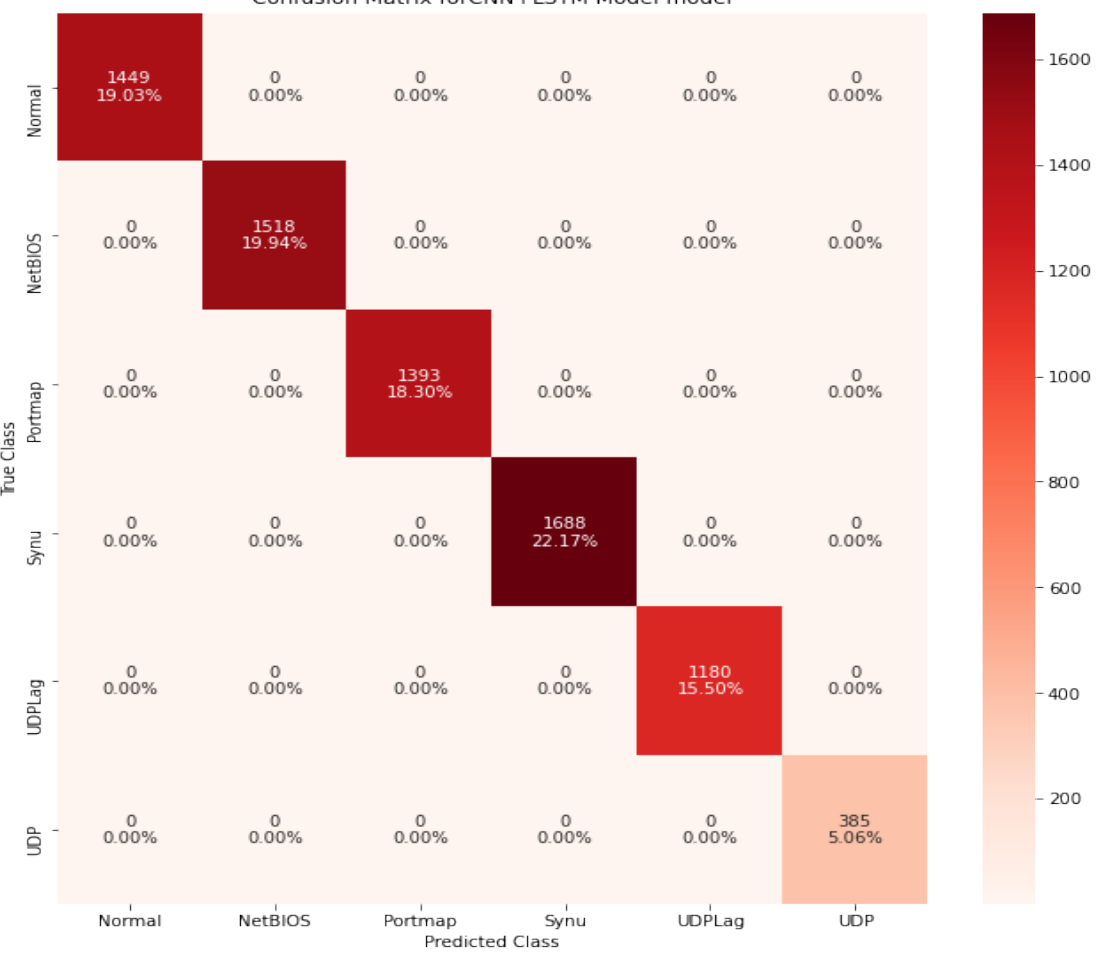
Figure 10. Confusion metrics of the CNN–LSTM model.